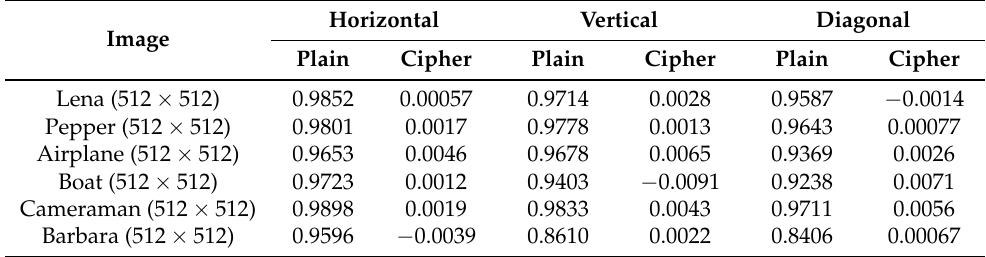
Table 5. Correlation